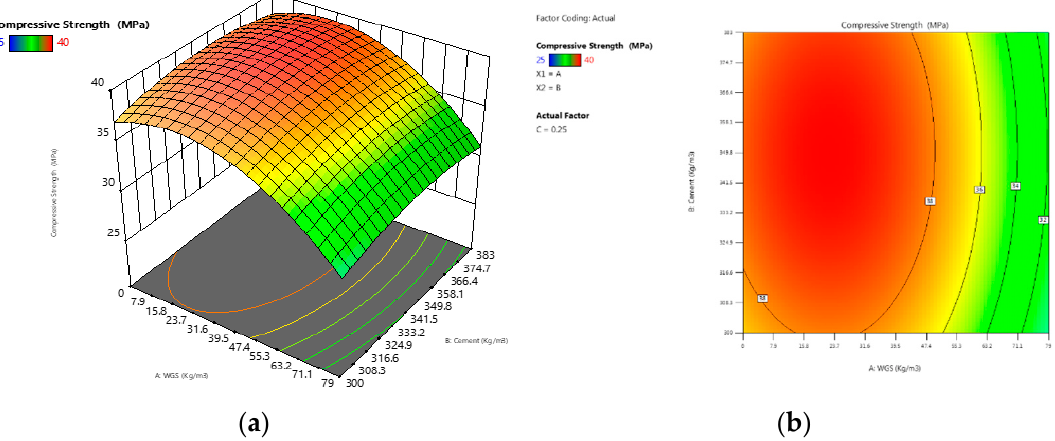
Figure 2. ( a ) The 3D surface diagram for compressive strength (WGS); ( b ) the 2D contour for compressive strength (WGS).